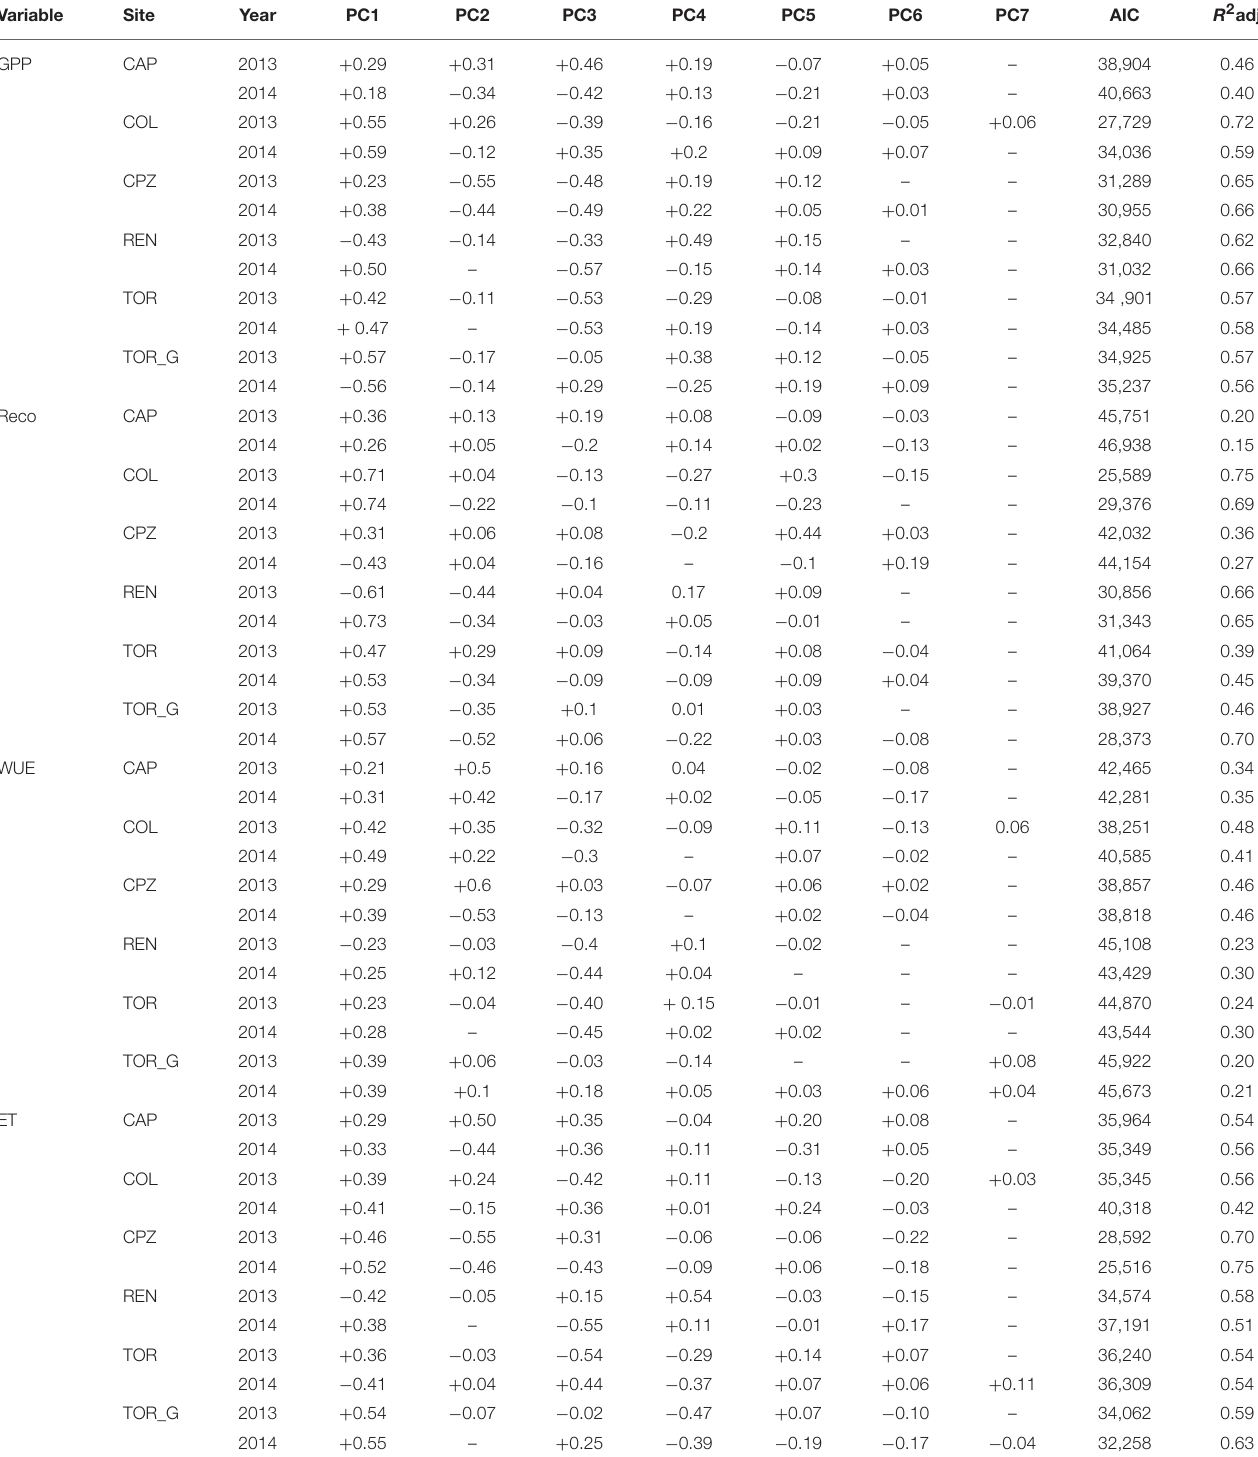
TABLE 3 | Linear regression models for GPP, Reco, and WUE as dependent variables.